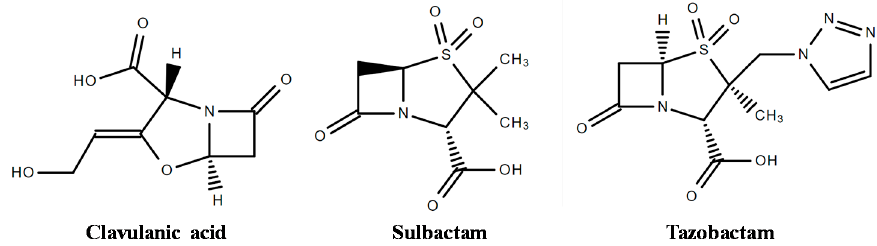
Figure 2. Chemical structure of β -lactamase inhibitors (Structures drawn in ChemSpider).